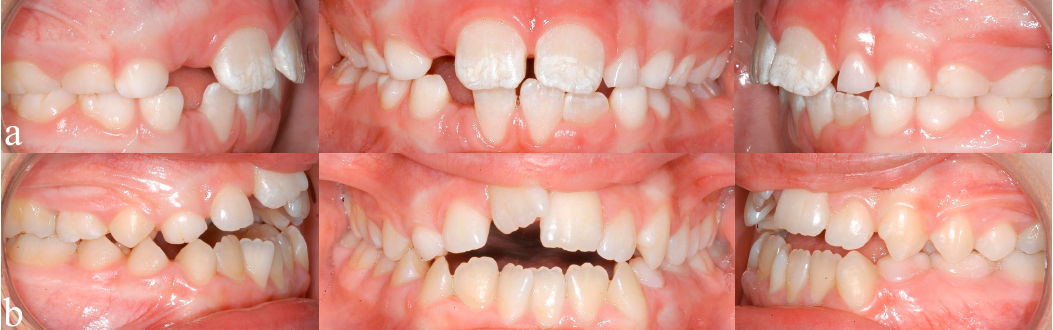
Figure 1. ( a ) Typical enamel opacities, in this case concerning the upper central incisors, ( b ) an anterior open bite configuration resulting from a sucking habit and mouthbreathing.